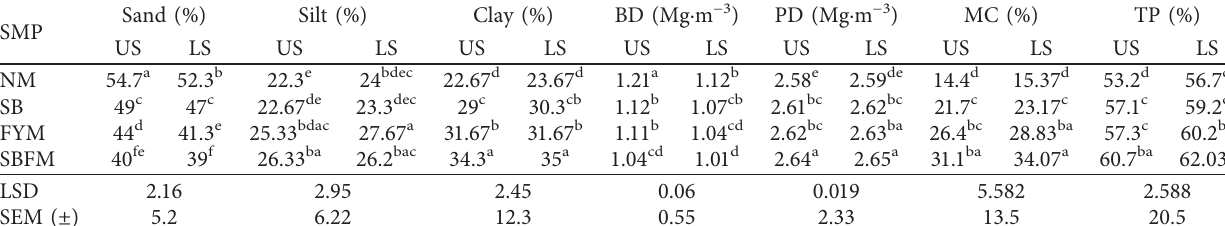
Table 3: Interaction effect of soil management practices and slope range on physical properties of the soils in Mawula watershed. Sand (%) Silt (%) Clay (%) BD (Mg · m − 3 SMP